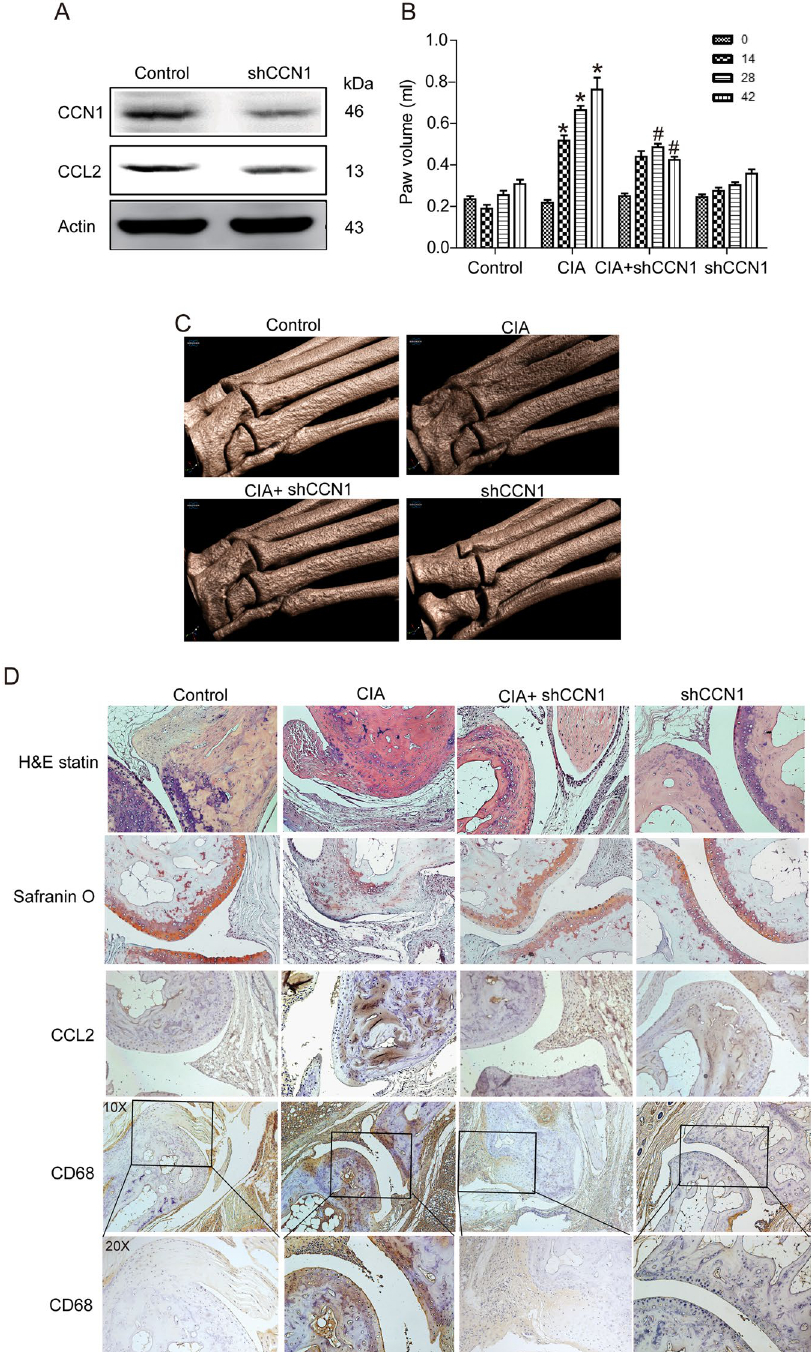
Figure 5. Lenti-shCCN1 attenuates bone erosion and monocyte migration in CIA mice. ( A ) CCN1 and CCL2 expression in control-shRNA MG63 and CCN1-shRNA MG63 cells was examined by Western blot analysis (n = 4). ( B ) The control and CIA mice were administered intra-articular injections of 7.1 × 10 6 PFU Lenti- shCCN1 on day 14 and sacrificed on day 42. Swelling of hind paws was measured by a digital plethysmometer (n = 5 per group). ( C ) Representative micro-CT images of the hind paws on day 42. ( D ) Histologic sections of ankle joints were stained with H&E or safranin O and immunostained with CCL2 or CD68; Scale bar, 50 μ m. Results are expressed as the mean ± S.E. * p < 0.05 compared with controls. # p < 0.05 compared with CCN1- treated